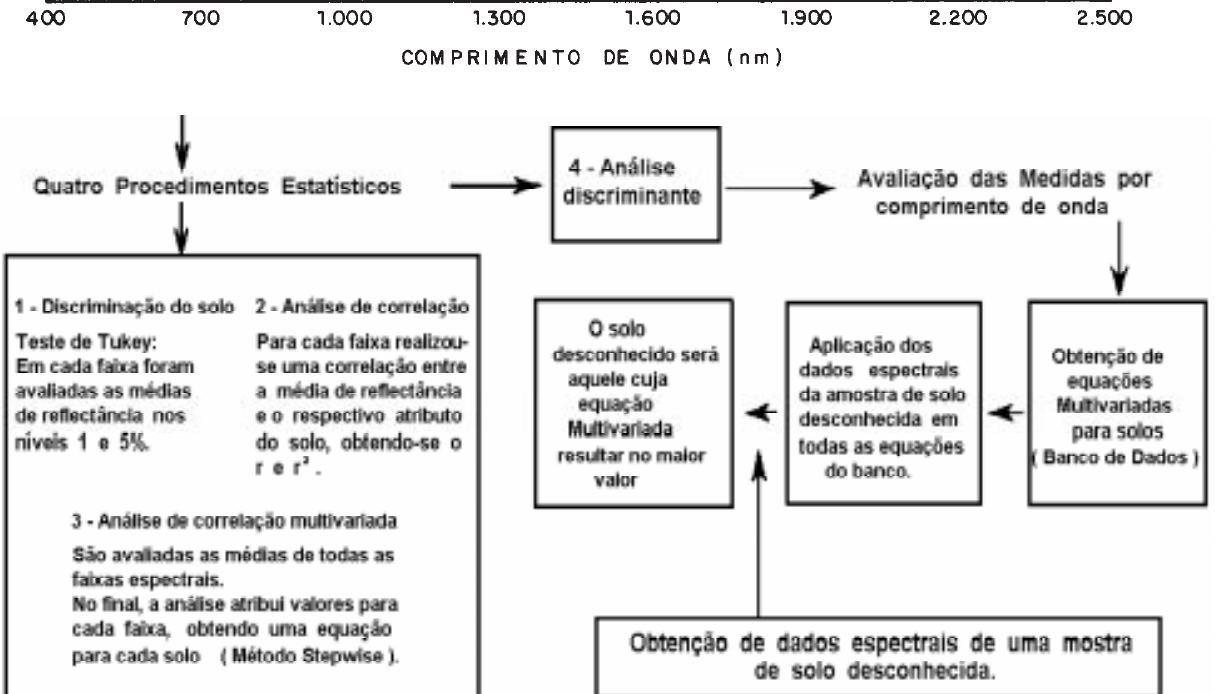
Figura 1. Fluxograma ilustrativo da obtenção e avaliação dos dados espectrais.